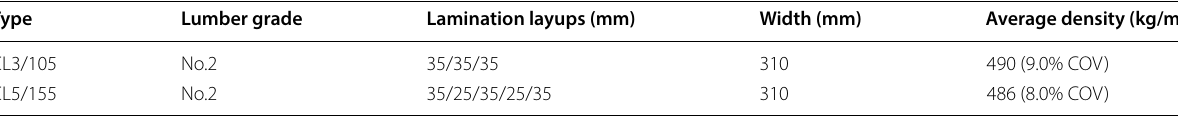
Table 1 Details of the black spruce CLT